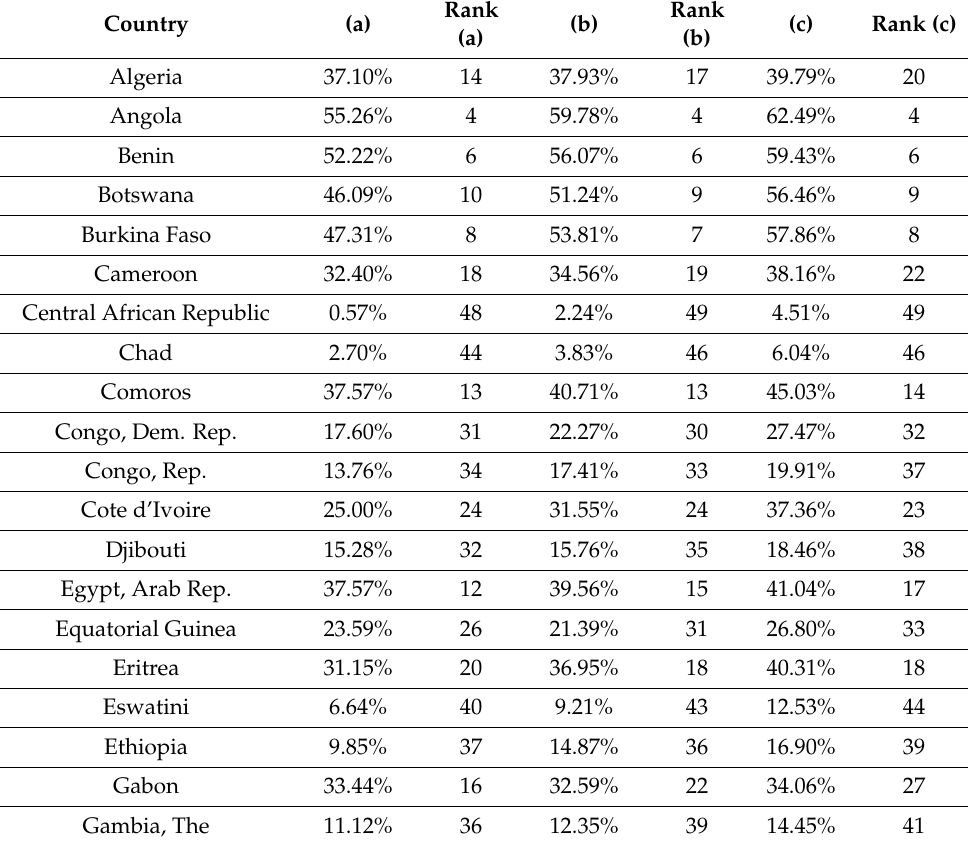
Table 10. Cumulative results for values of synthetic sustainable growth indices for the studied African countries in 2010–2018. Source: own